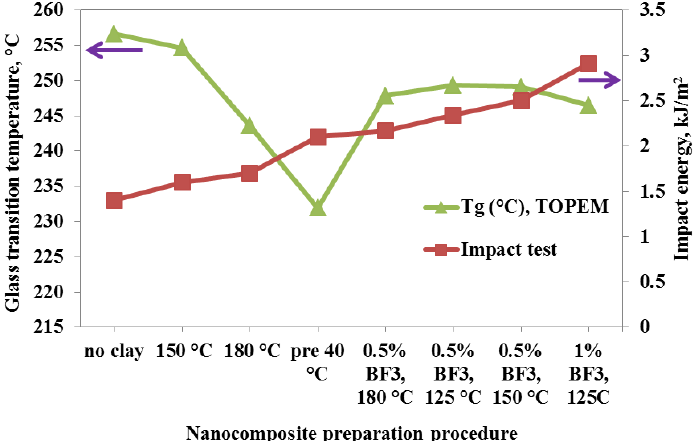
Figure 15. Variation of the dynamic glass transition temperature obtained by TOPEM (left hand axis) and impact energy (right hand axis) with preparation procedure for nanocomposites containing 2 wt%